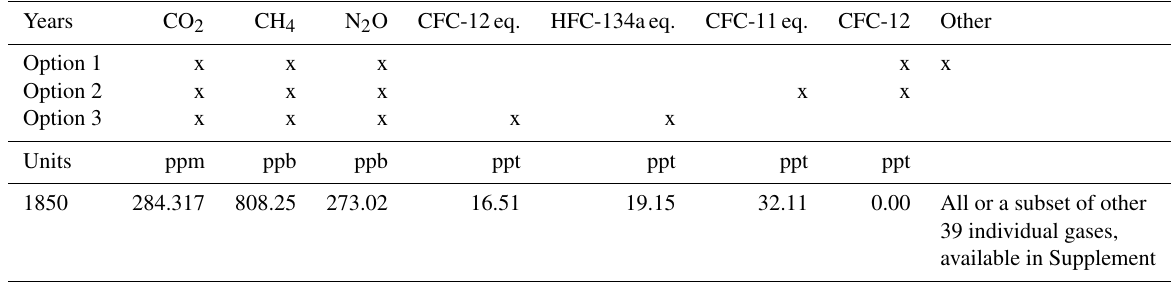
Table 8. picontrol: global- and annual-mean surface concentrations for the picontrol CMIP6 experiment. The hemispheric and latitudinally resolved concentrations for 43 GHGs and three aggregate equivalent concentrations are provided in the accompanying historical run dataset for the year 1850. The complexity reduction options for capturing all GHGs with fewer species than 43 are indicated in the table as Option 1, Option 2 and Option 3, with “x” denoting relevant columns under each option. Years CO 2 CH 4 N 2 O CFC-12eq. HFC-134aeq. CFC-11eq.